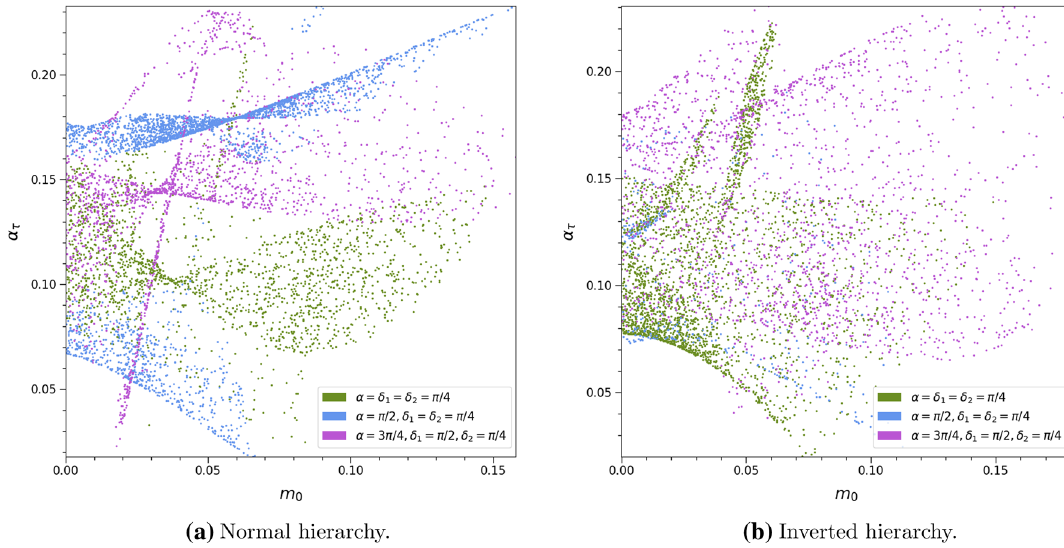
Fig. 8 Parameter space for α τ , with non-zero Majorana phases, as a function of the lightest neutrino mass m 0